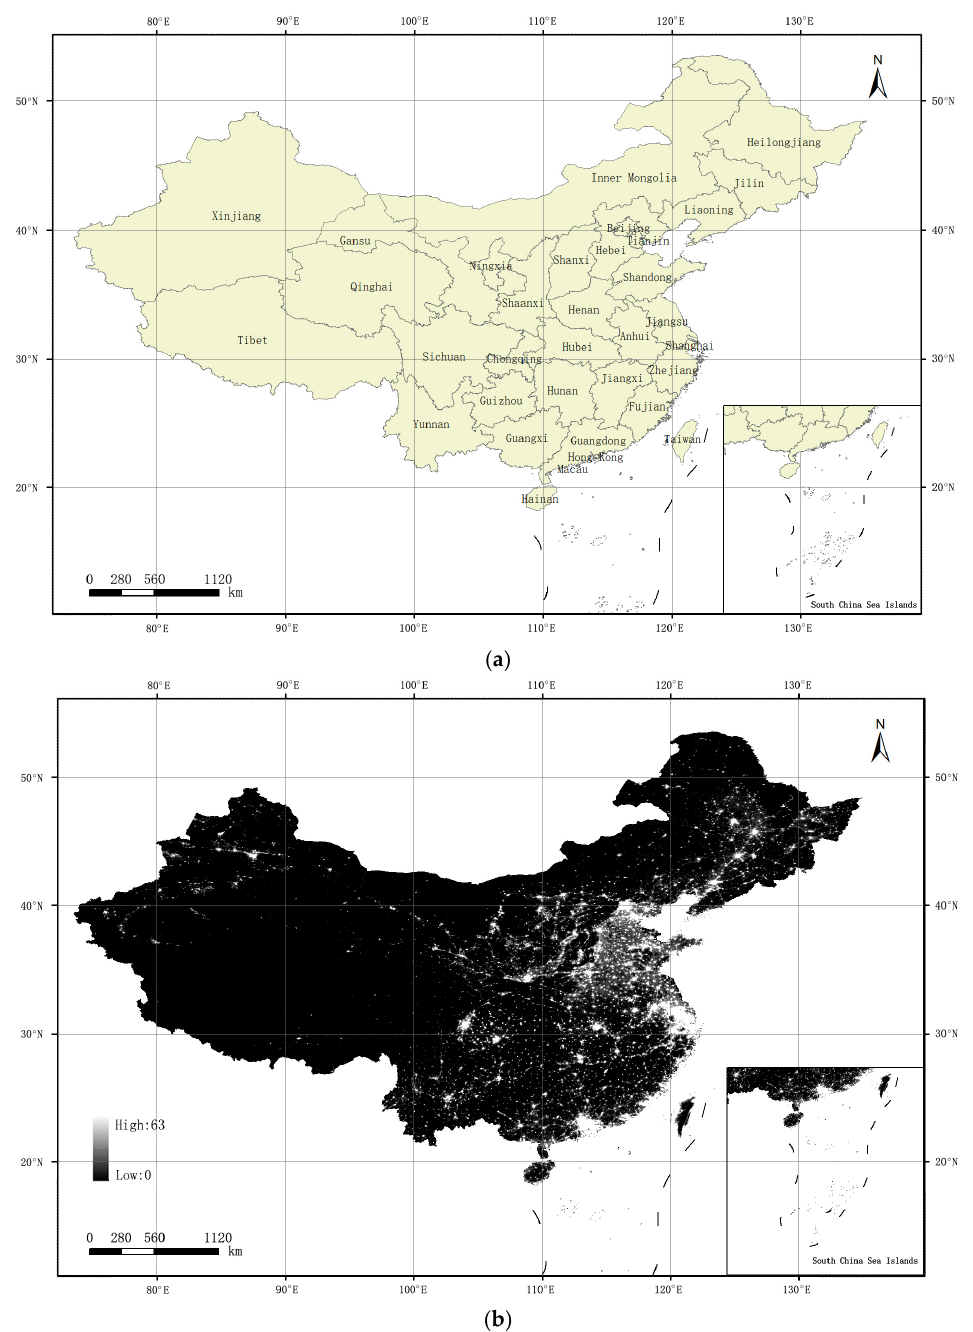
Figure 2. Provincial administrative division map and nighttime light image in China. ( a ) Provincial administrative division map; ( b ) Provincial nighttime light image.